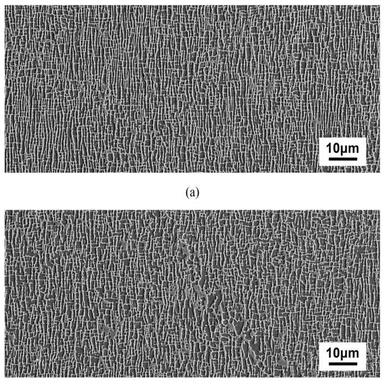
Typical crept microstructures of the investigated alloy at 1100 ◦C/120 MPa for 100 h.